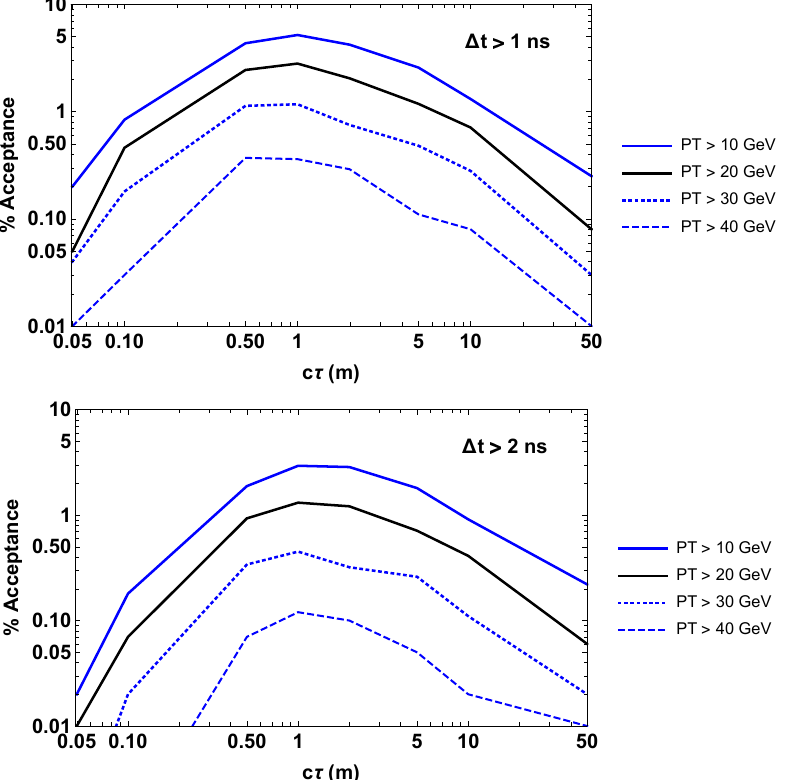
Figure 5 . Acceptance as a function of average decay length (m) for a right-handed neutrino mass, M = 50 GeV for two di(cid:11)erent timing cuts ((cid:1) t > 1 ns and (cid:1) t > 2 ns) in an Ecal timing based